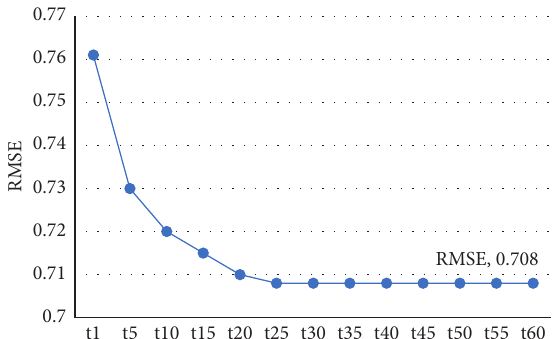
Figure 15: Performance of the number of iterations on Douban Movie.